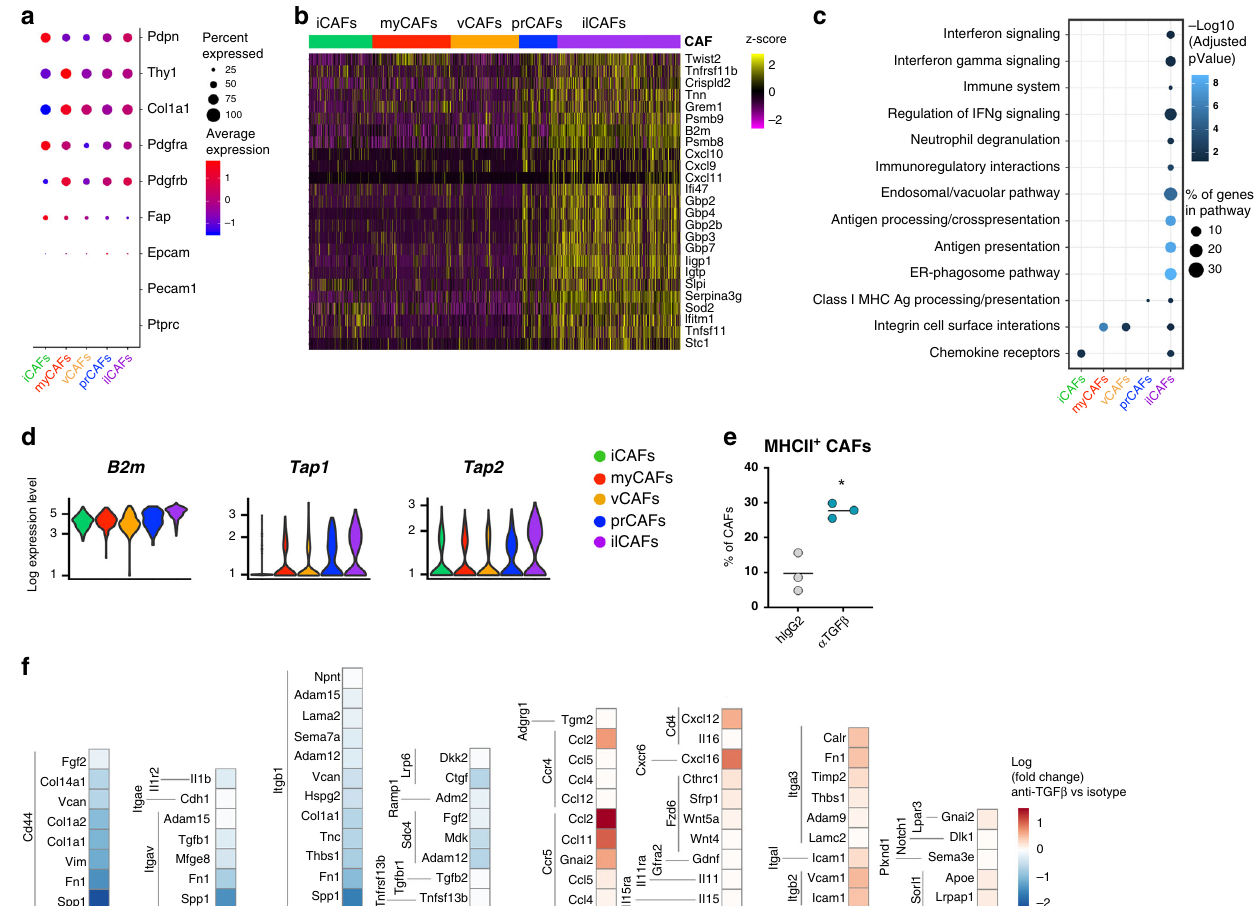
Fig. 5 ilCAFs exhibit an immunomodulatory transcriptomic signature. a Bubble plot outlining the expression of the indicated cell markers in the different CAF subsets. b Expression heatmap of the top 25 differentially expressed genes in ilCAFs. c Pathway enrichment analysis was performed on genes differentially expressed by ilCAFs using gPro fi ler (log(FC)> 1, Reactome pathways with p -value <0.05 were selected for, Fisher ’ s one-tailed test was used to calculate p -values, and p -values were adjusted for multiple testing). d Violin plots depicting expression of selected genes in CAF subsets. n = 4 mice per group from 2 independent experiments. e Flow cytometric analysis of MHCII expression by CAFs in isotype- and anti-TGF β -treated mice. Each dot represents a mouse. Mean is depicted. n = 3 mice per group from one experiment. * p = 0.0189 (unpaired, two-tailed t -test with Welch ’ s correction). f The differentially expressed receptor-ligand pairs between CAFs and T cells are shown ( p- value <0.05, calculated using Kruskal – Wallis TGF β -blockade augments T cell in fi ltration and activation . The remodeling of the CAF landscape after TGF β neutralization, and in particular the appearance of a CAF subset with potential T cell